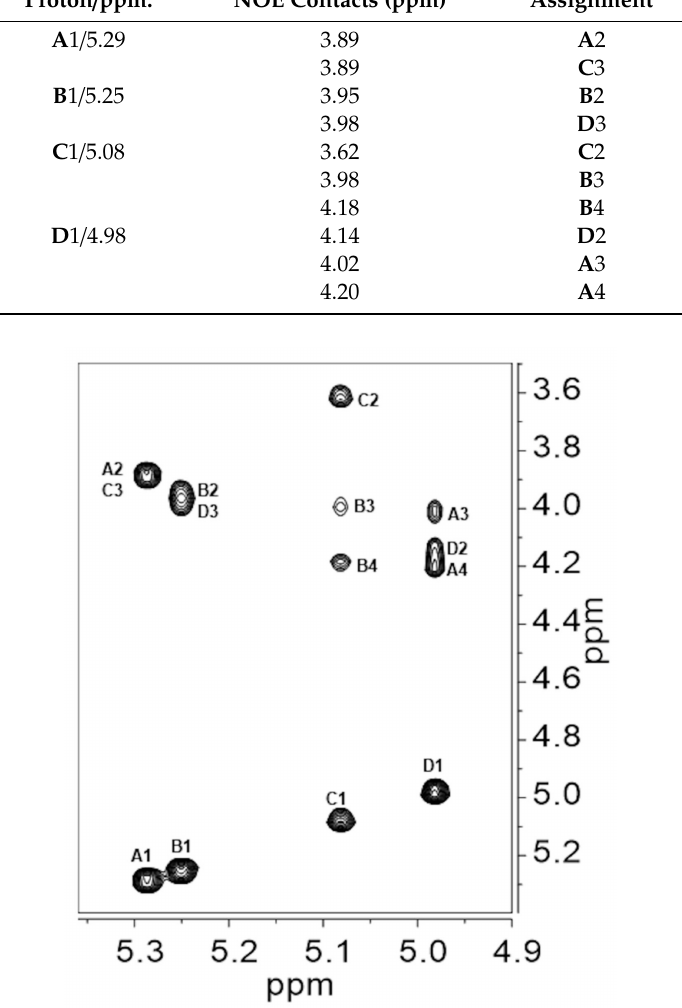
Figure 3. Anomeric region of the Nuclear Overhauser E ff ect SpectroscopY (NOESY) plot recorded at 50 ◦ C of Epol H111-INS extracted from the biofilm of B. cenocepacia H111. Intra- and inter-residues connectivities are shown. Proton cross peaks have been labelled according to the corresponding residue ( A to D ), as in Tables 1 and